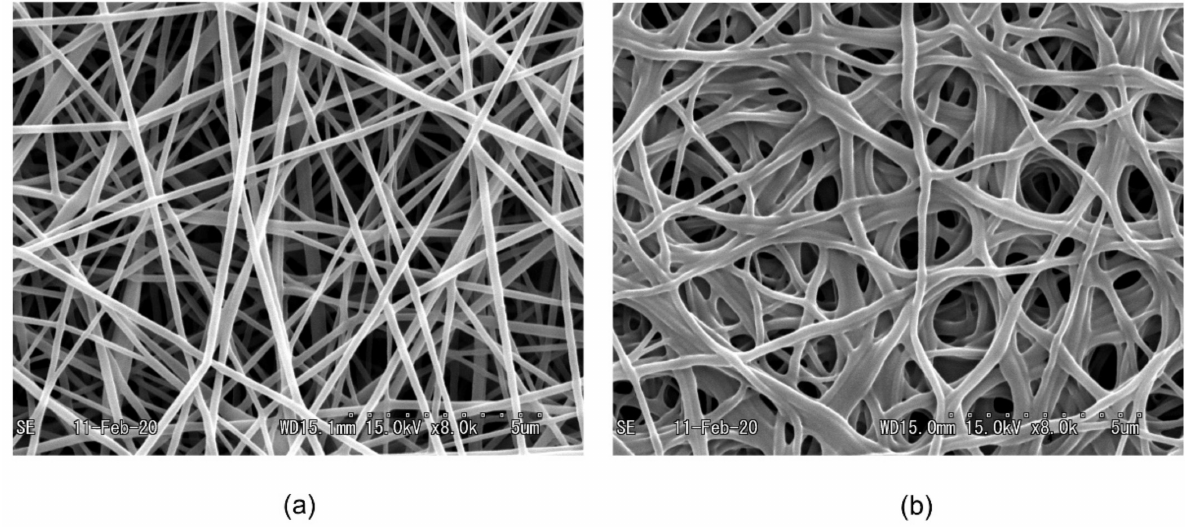
Figure 2. SEM images of ( a ) the original PVA nanofiber fabrics and ( b ) the CB-modified PVA nanofiber fabrics.